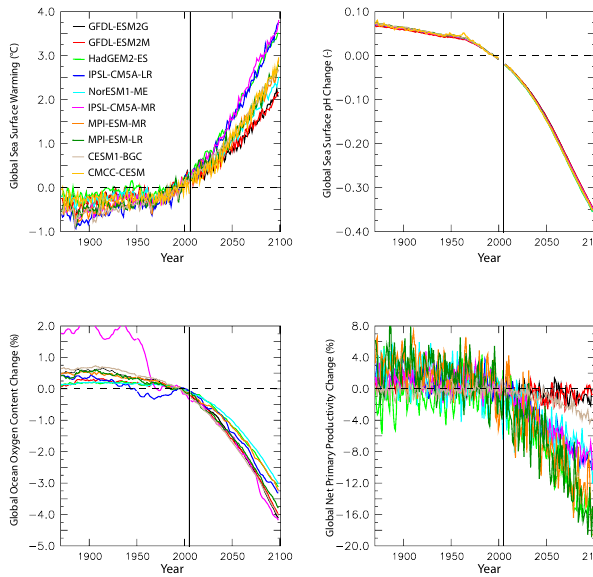
Fig. 3. Model-mean time series of global sea surface warming ( ◦ C), surface pH change (pH unit), ocean O 2 content change (%), and global NPP change (%) over 1870–2100 using historical sim- ulations as well as all RCP simulations. Shading indicates one inter-model standard deviation. All variables are plotted relative to 1990–1999.